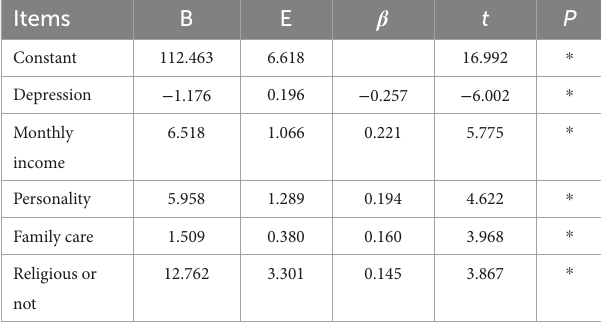
TABLE 3 Multivariate stepwise regression analysis of scores of the SMSE ( N =